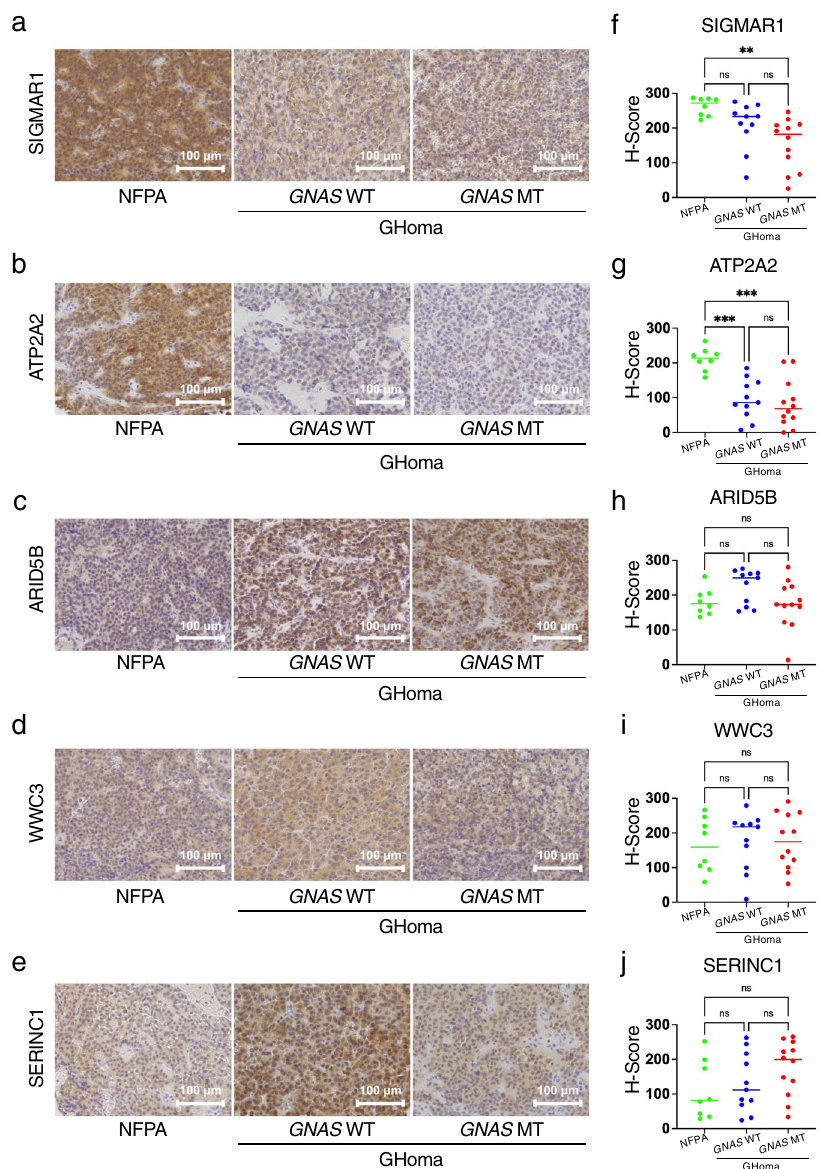
Fig. 7 Immunohistochemistry of differentially expressed candidates in nontargeted proteomics. Sections were stained for ( a ) sigma nonopioid intracellular receptor-1 (SIGMAR1), ( b ) sarcoplasmic/endoplasmic reticulum calcium ATPase 2 (ATP2A2), ( c ) AT-rich interaction domain 5B (ARID5B), ( d ) WWC family member 3 (WWC3), and ( e ) serine incorporator 1 (SERINC1). IHC scoring of ( f ) SIGMAR1, ( g ) ATP2A2, ( h ) ARID5B, ( i ) WWC3 and ( j ) SERINC1 was performed by modifying McCarty ’ s H-score. NFPA: nonfunctional pituitary adenoma/non-functioning pituitary neuroendocrine tumor (PitNETs), GHoma: GH-producing pituitary adenoma/somatotroph Pituitary neuroendocrine tumor (PitNETs). ** p < 0.01, ***p < 0.001 by 1-way ANOVA. n = 8 in NFPA, n = 11 in GHoma with GNAS WT, n = 12 in GHoma with GNAS